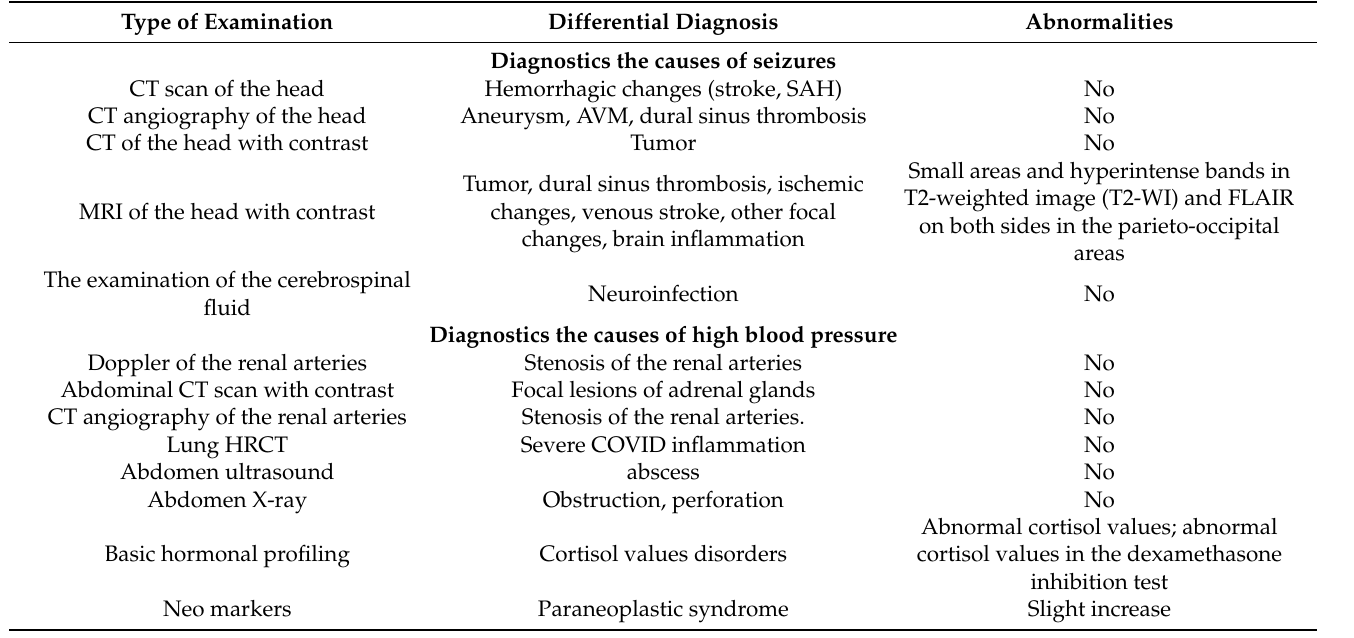
Table 2. Performed